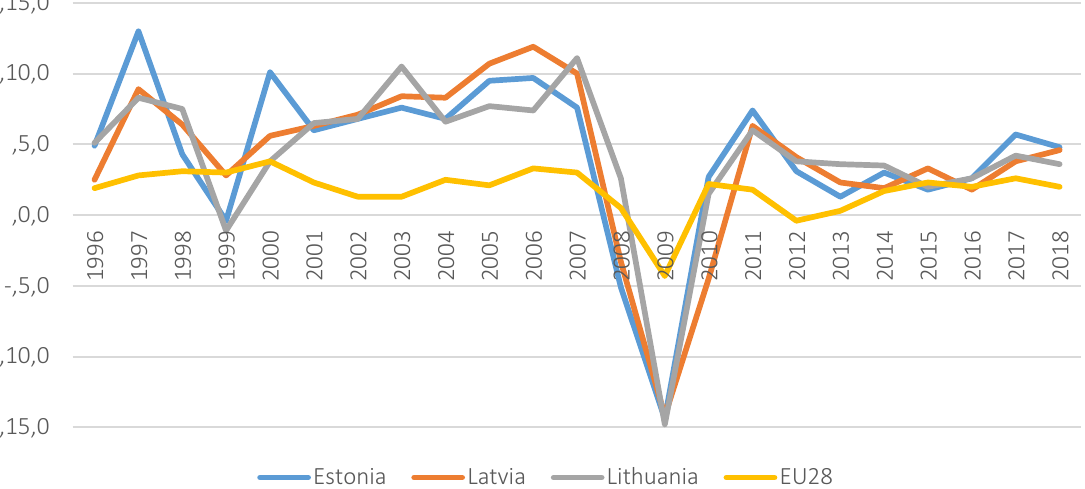
Figure 1. GDP growth rate: volume percentage change on the previous year in the Baltics and EU28, %